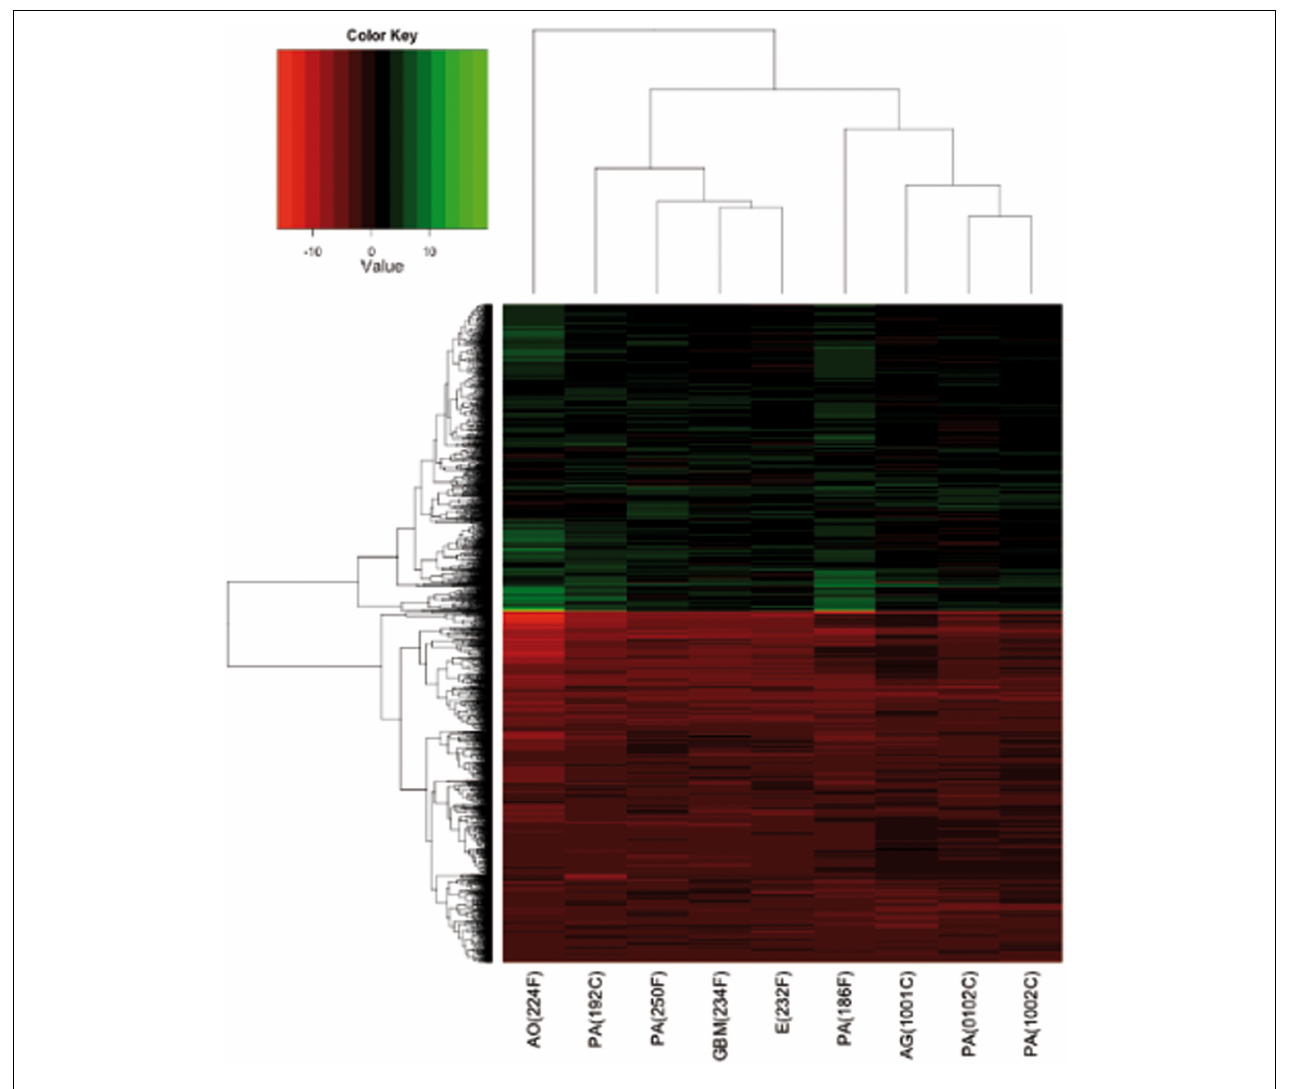
expression (log2 ratio), and give rise to groups of genes and samples with similar average expression levels, according to the color key, shown on the